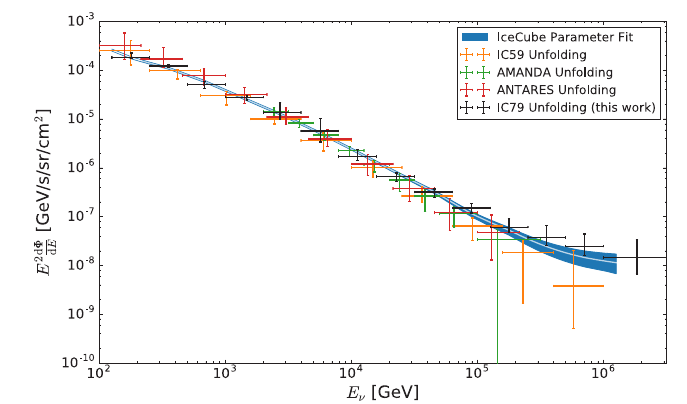
Figure 1 . Correlation of the input variables with the true energy of the neutrino for the IC-79 Figure 2 . Deconvolution results obtained for IceCube in the 59- (orange) and 79-string con- analysis. figuration (black), compared to an IceCube parameter fit (blue). Energy spectra obtained by ANTARES (red) and AMANDA (green) complete the